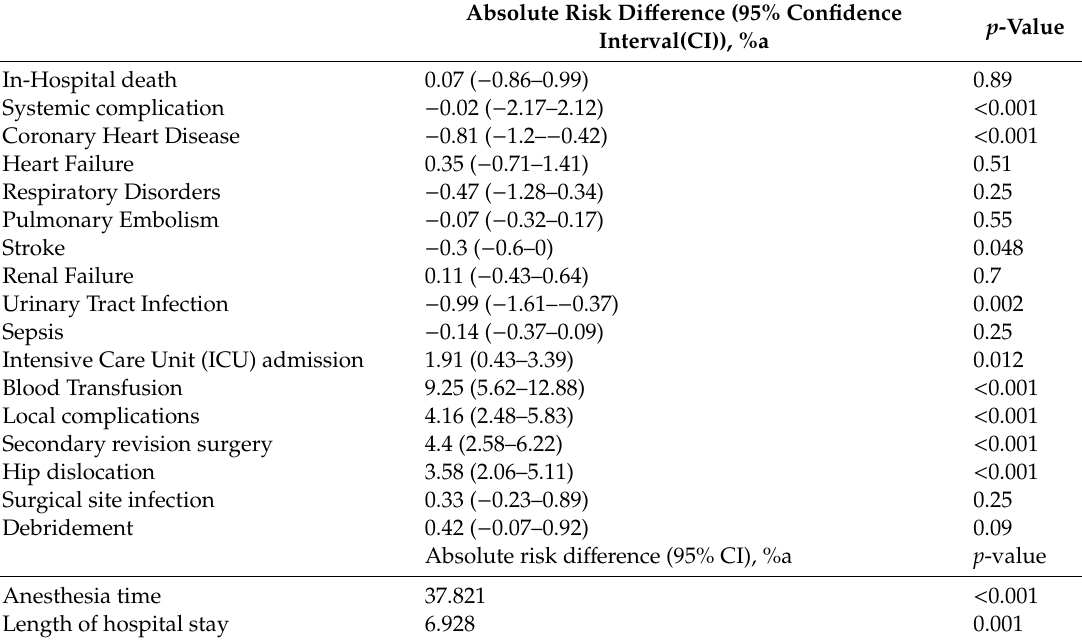
Table A4. Sensitivity analysis (Stabilized Inverse Probability